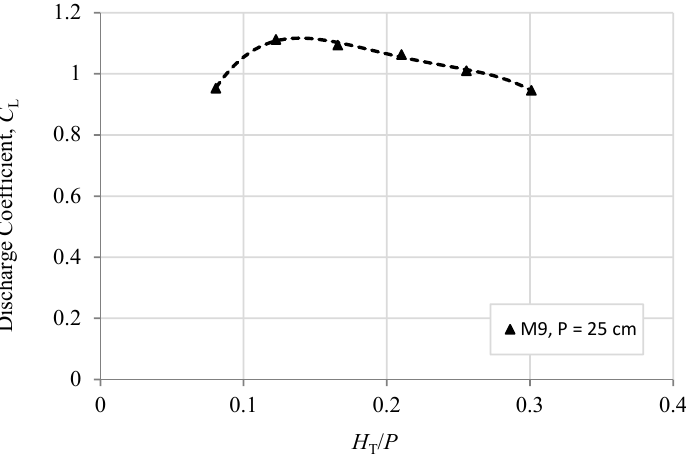
Figure 12. Variations in the discharge coefficient, C L , as a function of the H T /P ratio for the M8 model.